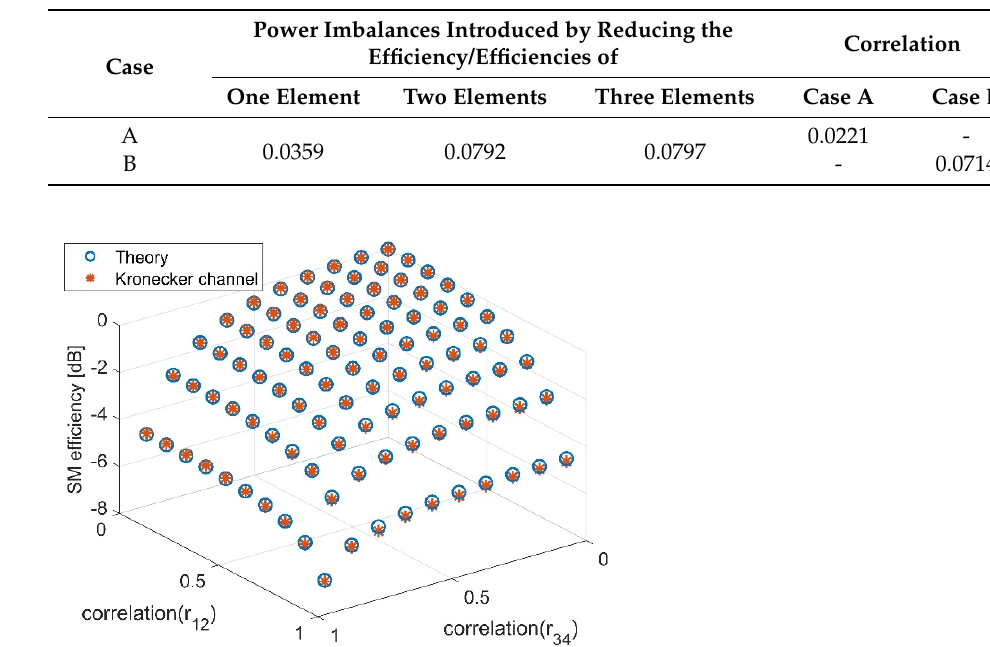
Figure 2. SM efficiency as a function of correlations in a 4 × 4 MIMO system. Table 1. RMSEs (dB) between simulated and theoretical SM efficiencies under different conditions.